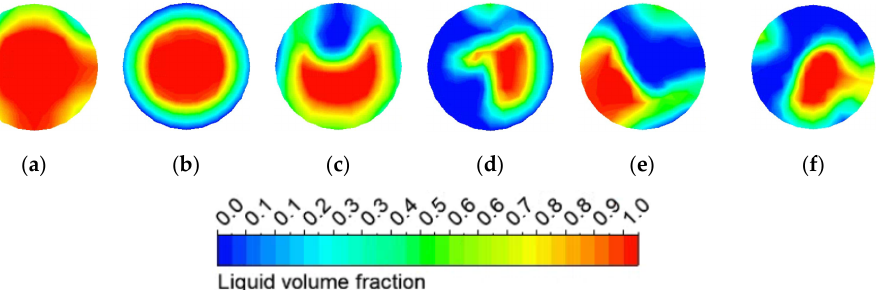
Figure 12. Vapor bubble distributions in capillary outlet section at different times: ( a ) 0.01 s ( b ) 0.05